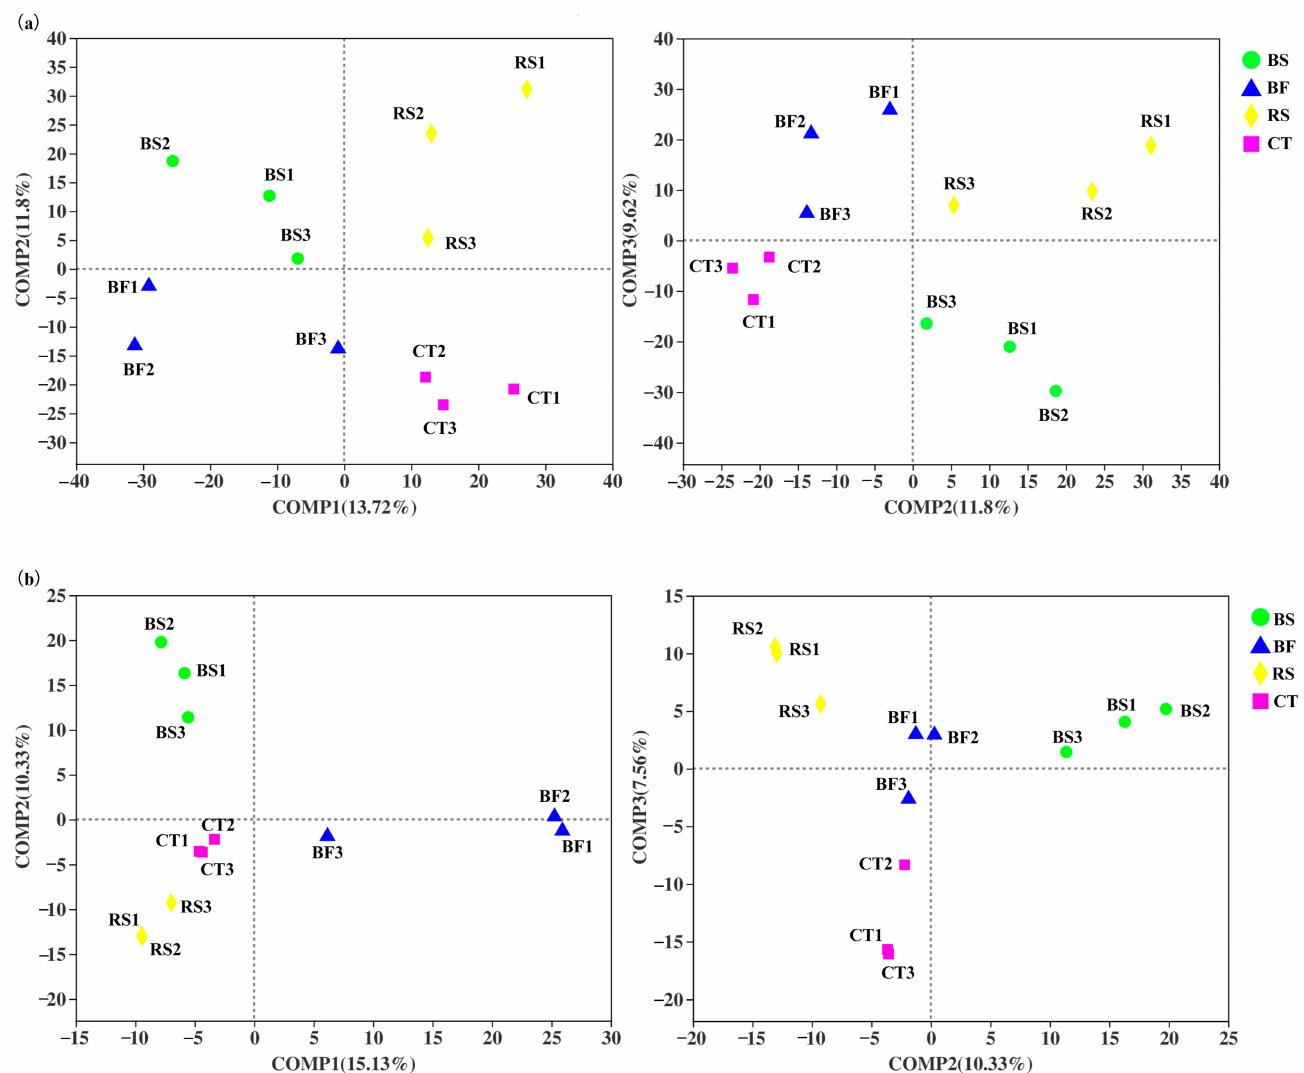
Figure 3. Partial Least Squares Discriminant Analysis score plots of bacterial ( a ) and fungal ( b ) communities for different soil and water conservation measures in the three soil depth